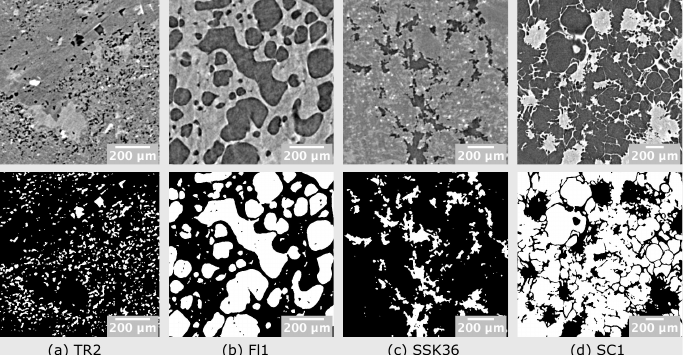
Figure 4. Raw and resulting processed images visualised using the freeware imageJ [25]. The upper row shows portions of reconstructed axial slices while the lower one shows the corresponding extracted pore phase after applying 3D median filtering, 3D automatic Otsu thresholding, erosion and dilation morphological filters.